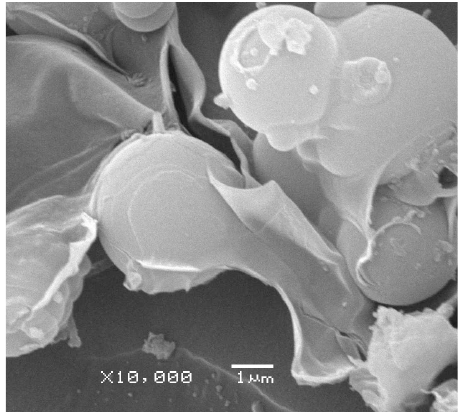
Figure 3. N 2 sorption isotherms of ( a ) LDH ‐ [C 6 H 5 COO], ( b ) LDH ‐ [Cr(SO 3 ‐ salphen)], ( c ) LDH ‐ [Mn(SO 3 ‐ salphen)], ( d ) LDH ‐ [Fe(SO 3 ‐ salphen)], ( e ) LDH ‐ [Co(SO 3 ‐ salphen)], ( f ) LDH ‐ [Cu(SO 3 ‐ salphen)].